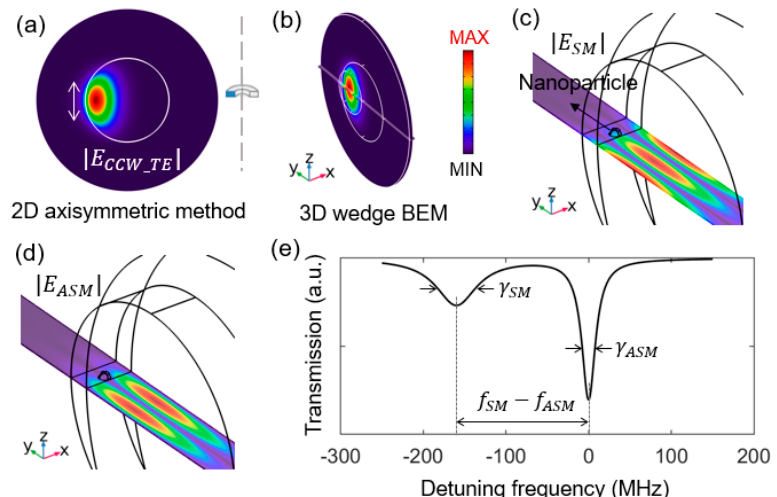
Figure 1. Electric field norm distributions of the traveling transverse-electric (TE) counter-clockwise (CCW) mode inside a bare microtoroid simulated using ( a ) 2D axisymmetric method and ( b ) 3D eigenfrequency. Electric field norm distributions of the ( c ) symmetric (SM) mode and ( d ) antisymmetric (ASM) mode were simulated using a 3D eigenfrequency model. The perturbative polystyrene nanosphere has a radius of 50 nm and is positioned with a 10 nm radial gap between it and the microtoroid equator. ( e ) Theoretically simulated mode splitting transmission spectrum. The SM mode experiences a frequency redshift of 2 g and a linewidth broadening Γ , which is quantified by a full width at half maximum linewidth in Hz. The color bar for all electric field norm distributions is given in ( b ).